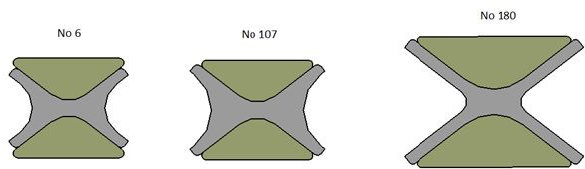
The independent variables were the parameters de- scribing the strength of materials, which determined some limitations of the searched area of the optimal design. The